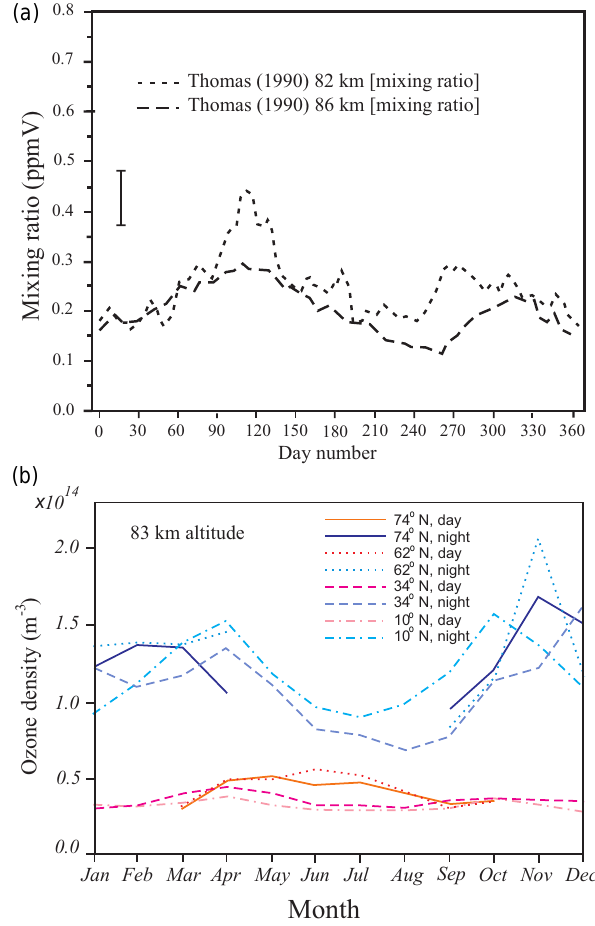
Figure 5. (a) Plots of satellite-measured ozone volume mixing ratio (parts per million by volume) at 82 and 86km, at 45 ◦ N. Increases in ozone ppmv in spring and autumn are evident. (b) Night and day- time seasonal variations for O 3 density from the WACCM model at 83km altitude, for latitudes close to the four radar sites. The upper set of graphs is for night-time, and the lower set is for daytime. Val- ues were obtained at local midnight (“night”) and midday (“day”). Our interest here is in solar effects, so for the two more northerly latitudes (Yellowknife and Resolute Bay) daytime data have been removed for November through to February (since the sun is largely absent in those months), while night-time values have been removed for May through August (since darkness is relatively rare in those months at high latitudes). Similar trends to (a) may be seen, with lowest overall values in summer. Both (a) and (b) show peaks in night-time activity around the equinoxes, though (a) shows a more pronounced local minimum in winter